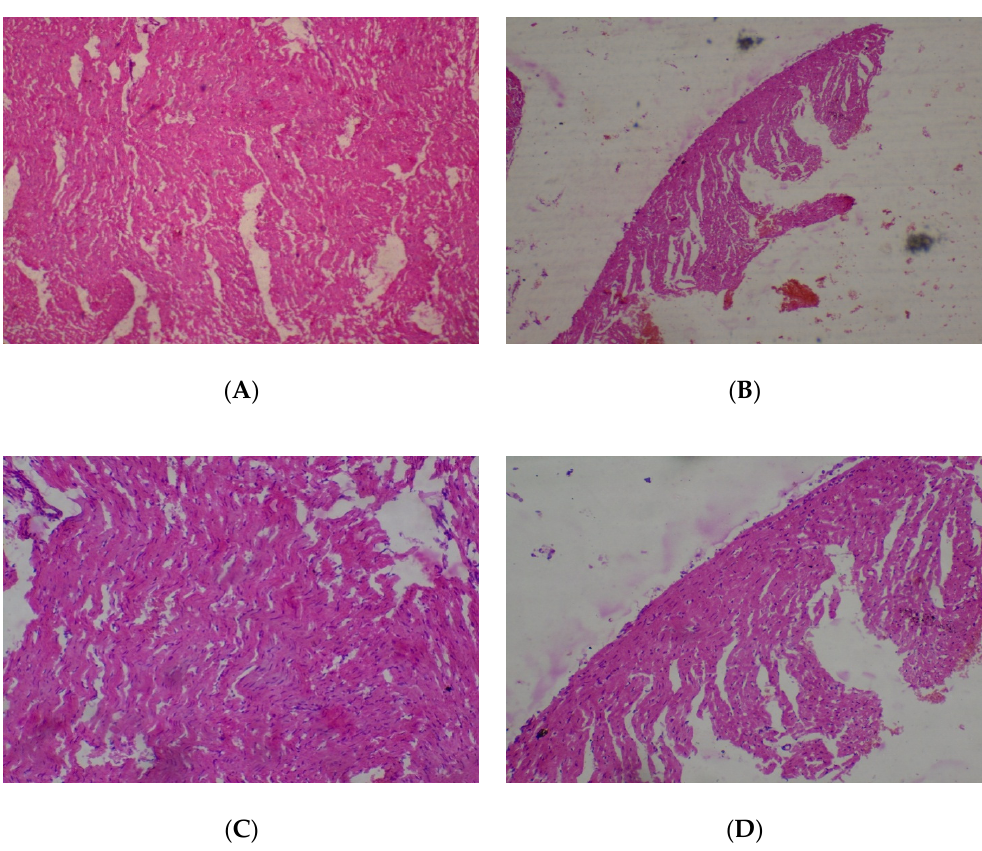
Figure 2. Histopathological presentation of rat heart. ( A ) represents the control group treated with distilled water (Normal); ( B ) represents the group treated with 80 mg/kg of T. occidentalis extract (Normal); ( C ) represents the group treated with 400 mg/kg T. occidentalis extract (Normal) and ( D ) represents the group treated with 2000 mg/kg T. occidentalis extract (Normal) ( × 400). Histologic sections of heart muscle show interlacing fascicles of cardiac myocytes/myocardial cells. No other abnormalities are seen.